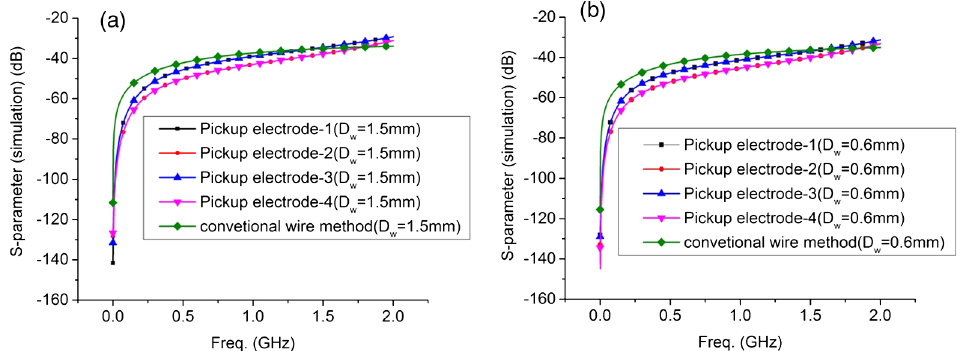
FIG. 16. S-parameters obtained through simulation of conventional and modified (pickup electrode 1 to 4) coaxial wire methods for the calculation of transfer impedance of IDBPI. (a) 1.5 mm wire diameter and (b) 0.6 mm wire